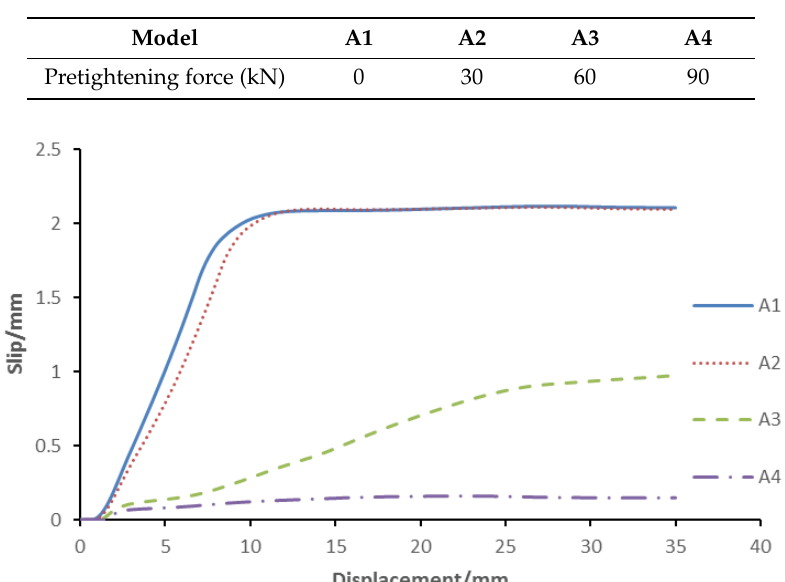
Figure 20. Force-displacement curves. 3.3.2. Number of Bolts Under the premise of ensuring the safety of the specimen, it is necessary to determine the most economical and reasonable number of bolts. On the basis of the numerical model in Section 3.2, the changes of the number of bolts are achieved by deleting bolts in different locations. According to Chinese Standard GB50017-2003 [52], the maximum distance between bolts in this paper is 192mm. The specific number of bolts is shown in Table 5. Through the numerical analyses, the force-displacement curves and slip-displacement curves are shown in Figures 21 and 22, respectively. In Figure 21, the initial slips of B1–B5 all occur at the horizontal displacement of 1.38 mm, and the end slips occur at the horizontal displacement of 11.8 mm, 11.2 mm, 10.5 mm, 10.5 mm, and 9.4 mm, respectively. This means that the slip of the model is not sensitive to the number of bolts. In Figure 22, the stiffnesses of B1–B5 decrease by 69.4%, 70.1%, 70.6%, 70.8%, and 71.3% from the start of slip to the end of slip, respectively. Although a reduction of bolts can cause the stiffness degradation to become greater, the stiffness degradation ratios are approximations only. It is concluded that the changes of the number of bolts have little effect on the slip when the number of bolts meets the earthquake-resistant detail requirement and transmitted force need. In other words, in designing a connector for the PC shear wall, when the number of bolts is satisfied with the detail requirement and transmitted force need, the number of bolts can be reduced. Table 5. Number and arrangement of bolts.